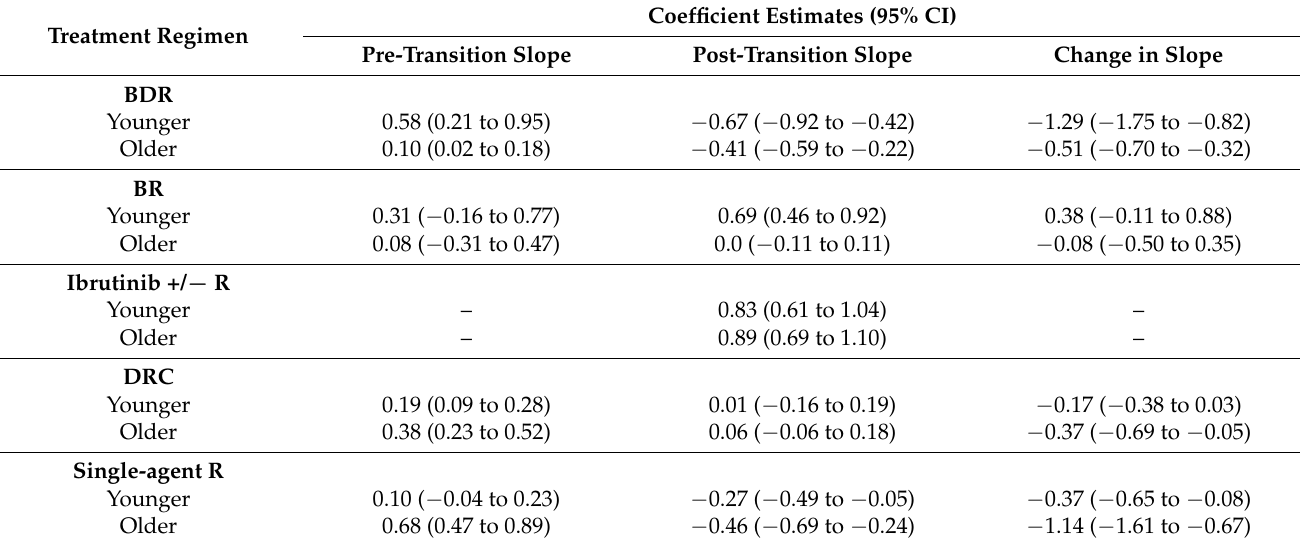
Table 4. Segmented regression